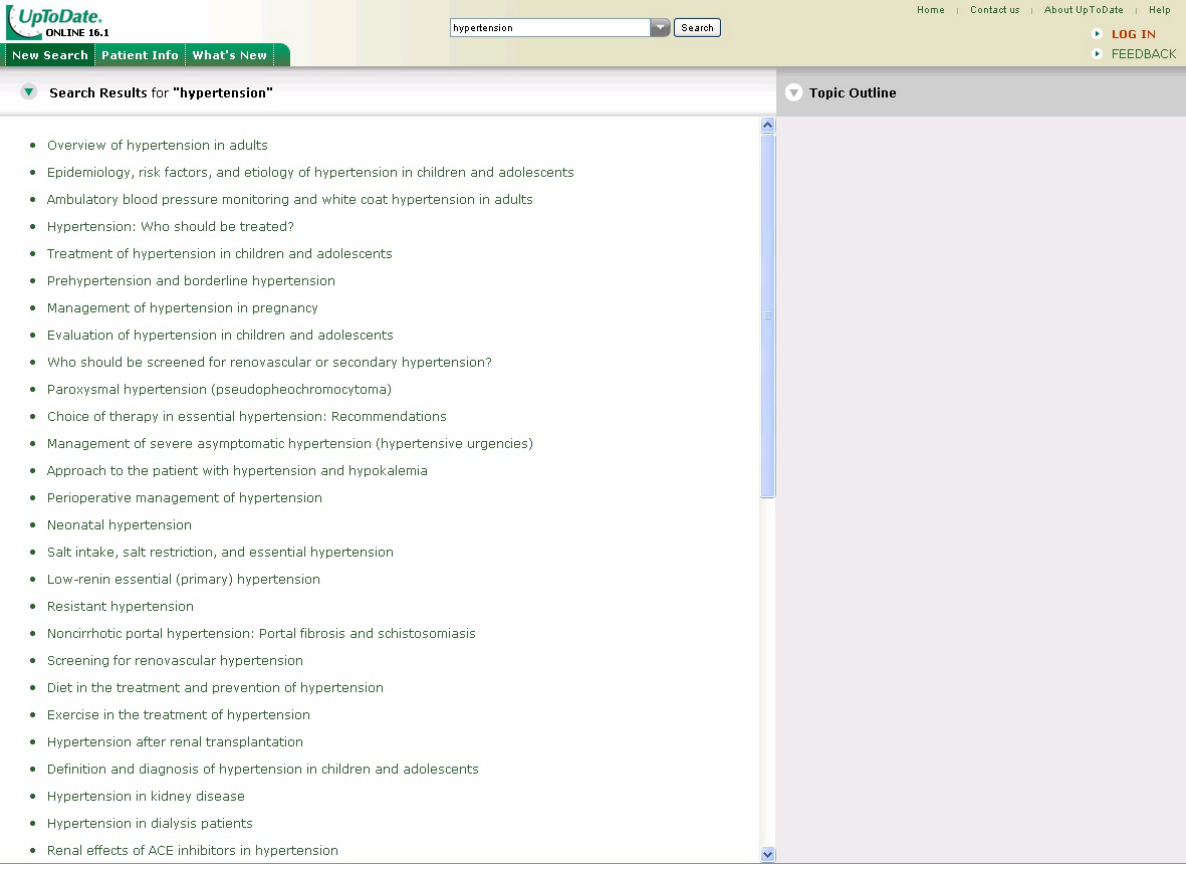
Figure 3. Screenshot of the UpToDate interface (Reproduced with permission from UpToDate, Rose BD, editor, UpToDate, Waltham, MA, 2008. Copyright 2008 UpToDate, Inc.